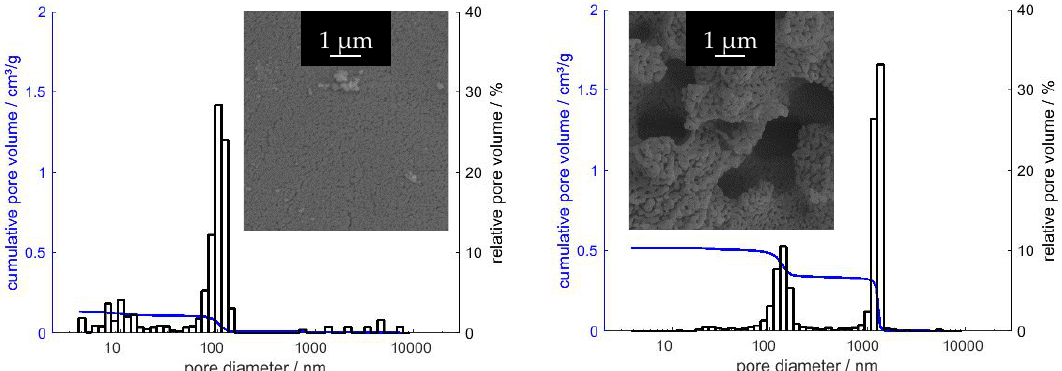
Figure 5. Mercury instruction histograms and SEM images of the starting point syntheses SG-Ref0 (left, without polyethylene oxide [PEO]), and SG-Ref100 (right, with addition of PEO of Mm 900,000). Both samples were calcined at 1200 °C for 6 h.